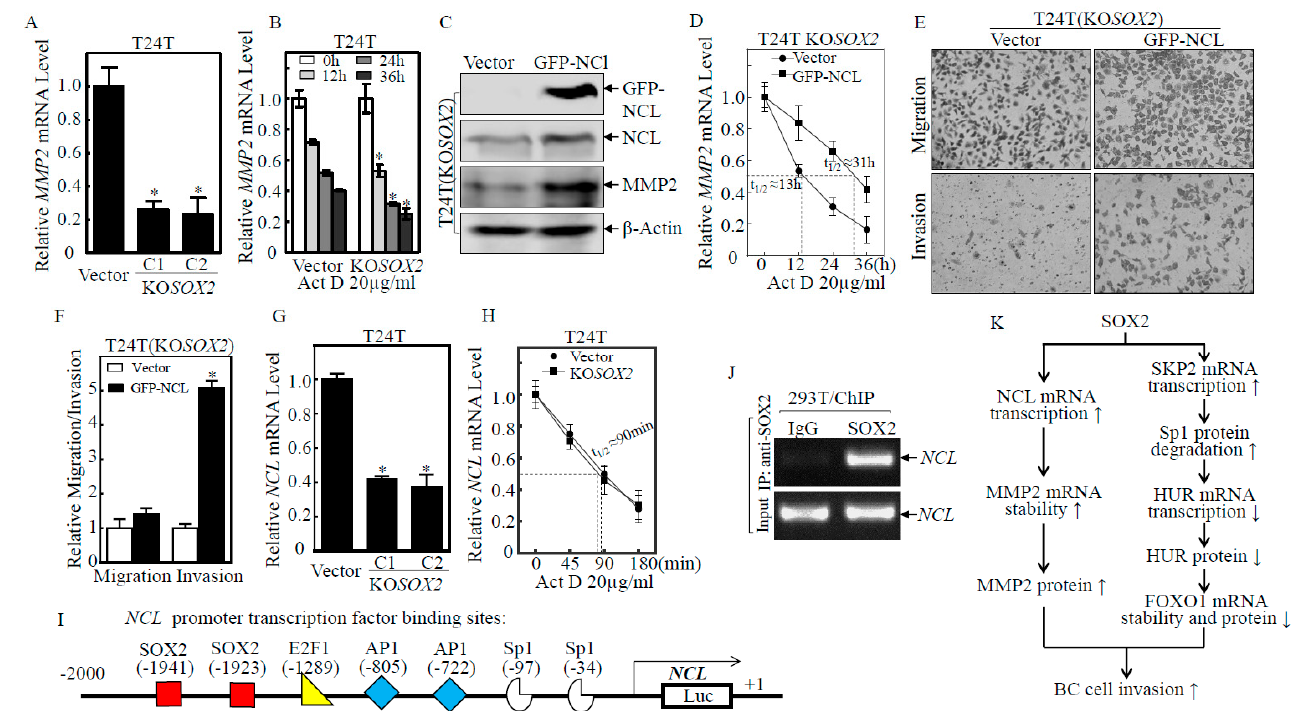
Figure 6. SOX2 promoted transcriptional nucleolin upregulation and in turn increased the stability of MMP2 mRNA and protein expression, further promoting the invasion of BC cells. ( A , G ) Real-time PCR was applied to compare the mRNA levels of MMP2 and NCL in T24T(Vector) and T24T(KO SOX2 C1/C2) cells. The asterisk (*) indicates a significant difference in MMP2/NCL mRNA in comparison to its vector control transfectant ( p < 0.05). ( B , D , H ) The indicated cells were seeded into six-well plates. After synchronization, the cells were treated with Act D for the indicated time points, then total RNA was isolated and subjected to RT-PCR analysis to evaluate the mRNA levels of MMP2 or NCL . ( C ) T24T(KO SOX2 /Vector) and T24T(KO SOX2 /GFP-NCL) cells were cultured in six-well plates until the cell density reached 80–90%. The cells were then extracted, and the cell extracts were subjected to Western blot to determine the expression level of the indicated proteins. β -Actin was used as a protein loading control. ( E , F ) The invasion abilities of T24T(KO SOX2 /Vector) and T24T(KO SOX2 /GFP-NCL) cells were determined using a BD BioCoat TM Matrigel TM Invasion Chamber. The asterisk (*) indicates a significant difference in invasion abilities in comparison to its vector control transfectant ( p < 0.05). The bars are presented as the mean ± SD from three independent experiments. ( I ) Potential transcriptional factor binding sites in the NCL promoter region ( − 2000–+1) were analyzed using the TRANSFAC 8.3 engine online. ( J ) The 293T cells with overexpressed SOX2 were employed for ChIP assay using an anti-SOX2 antibody to test the interaction of SOX2 with NCL mRNA. ( K ) Schematic summary of molecular mechanisms underlying SOX2 promotion of invasion of human BC cells. SOX2 stabilizes MMP2 mRNA and thereby upregulates MMP2 protein by promoting transcription of NCL. In addition, SOX2 transcriptionally activates SKP2, which promotes the degradation of Sp1 and reduces its transcriptional activation of HUR, thereby downregulating FOXO1 mRNA stability and FOXO1 protein. Increased MMP2 and decreased FOXO1 together promote BC invasion.